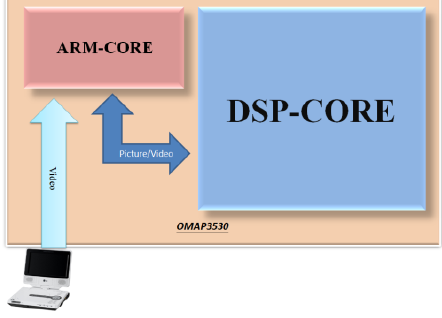
Figure 10. The software architecture of the VIDASS system on the ARM-DSP